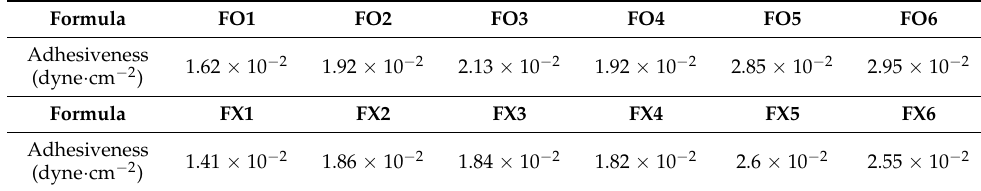
Table 6. Adhesiveness (stickiness) of the orodispersible films.